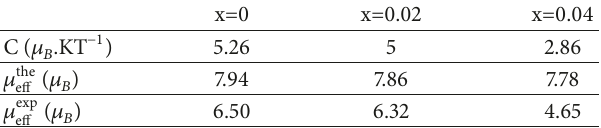
( 𝜇 ), and 𝜇 exp B eff